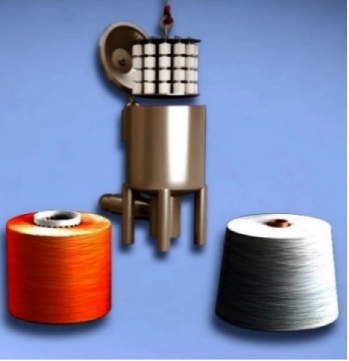
Figure 1. Raw material cone, plastic dyeing tube and dyeing machine [Courtesy of EL Sharq El Awsat Co.].